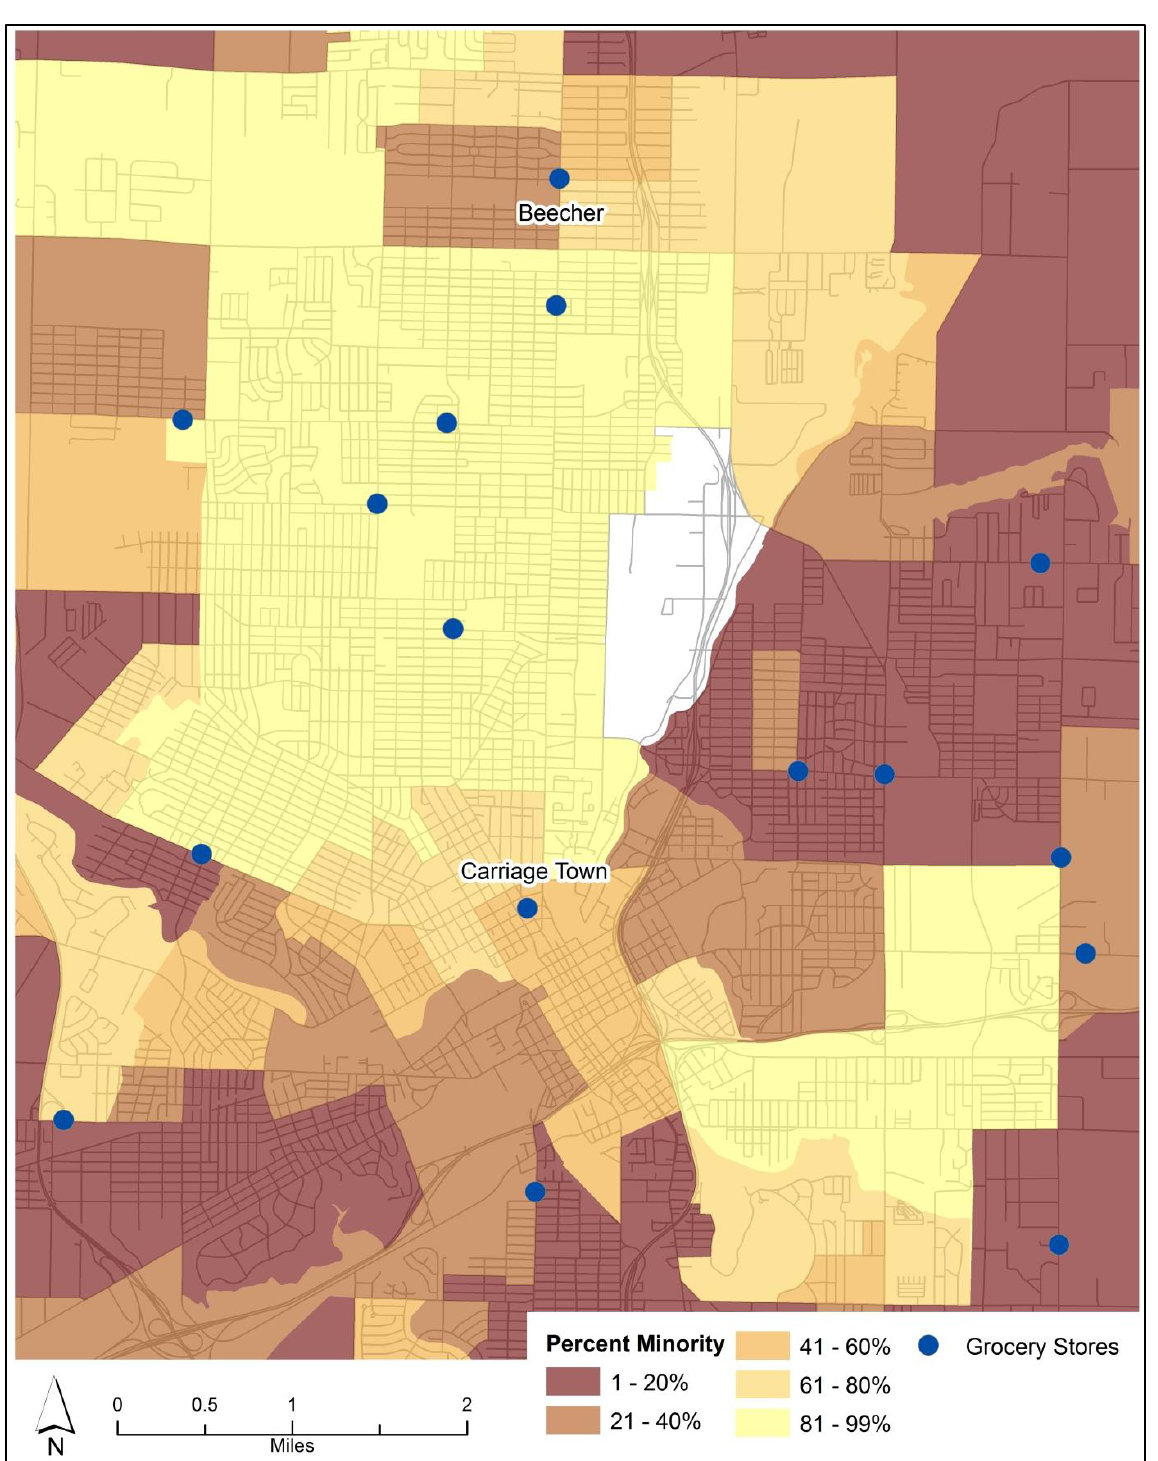
Figure 1. Percent of Minority Residents by Census Block Group (US Census Bureau, 2010)